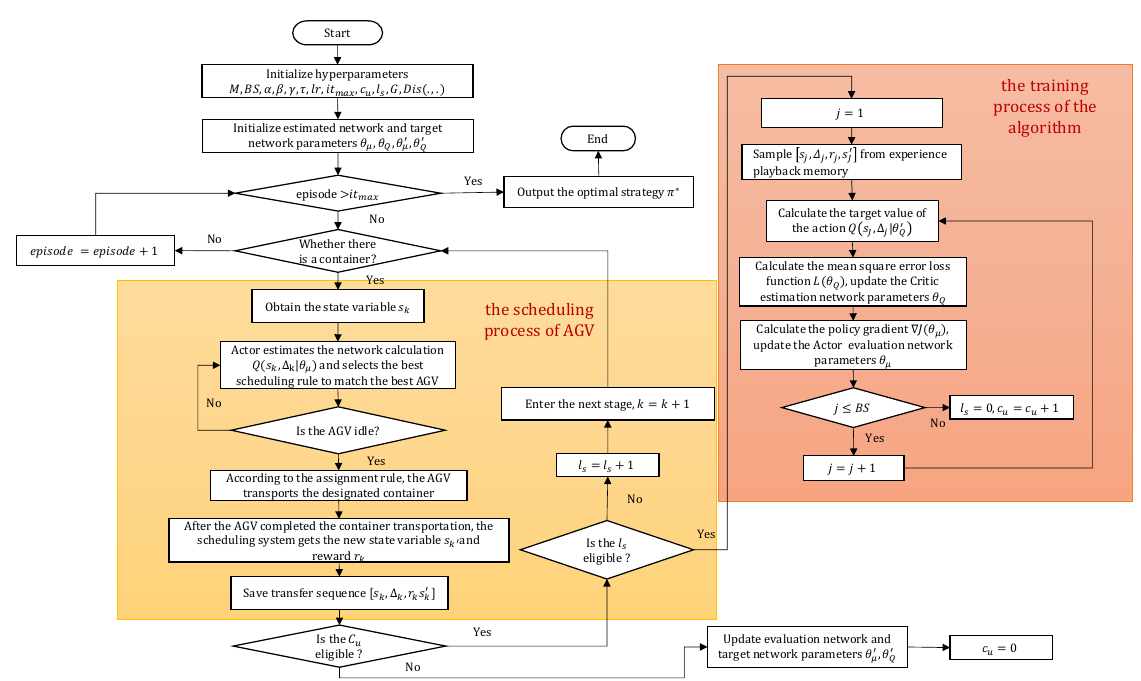
Figure 4. Dynamic scheduling process of AGV based on CDA